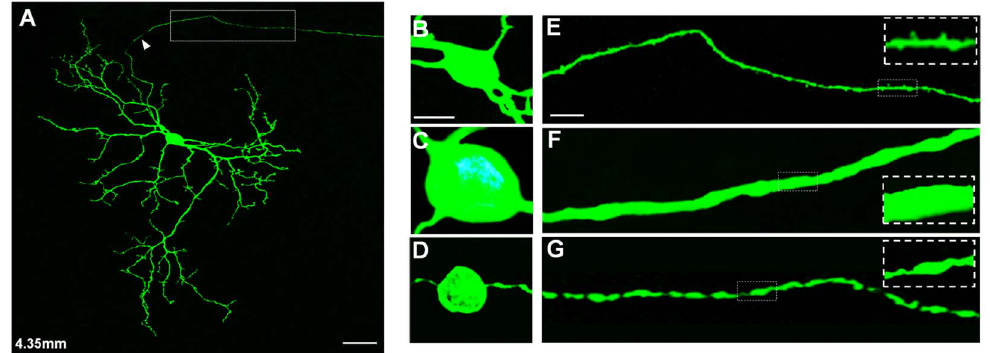
Figure 4. Details in morphology of caudal periaqueductal gray (cPAG)-projecting retinal ganglion cells (RGCs). (A) A photomontage of cPAG-projecting RGC. This cell lies at 4.35 mm from the optic disk. The arrowhead points to an axon. (B–D) High power photomicrographs comparing somata among cPAG-projecting RGC (B), alpha cell (C) and melanopsin-expressing RGC (D). (E–G) High power photomicrographs comparing axons among cPAG-projecting RGC (E), alpha cell (F) and melanopsin-expressing RGC (G). The white frames highlight parts of their axons, respetively. Scale bars: 20 m m in A; 10 m m in B (applies to C and D); 5 m m in E (applies to F and G).